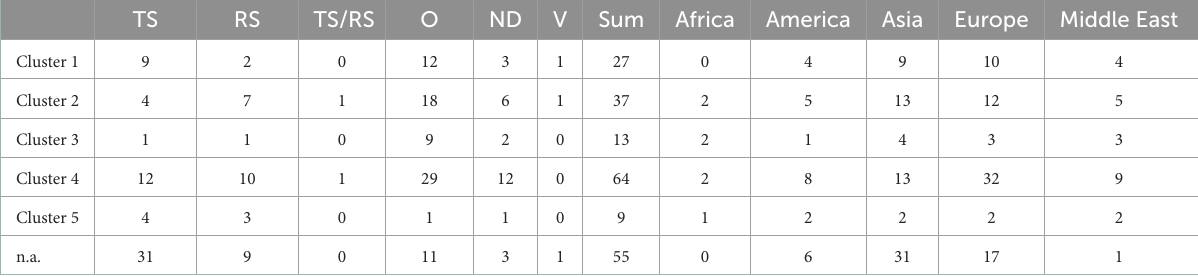
TABLE 1 Distribution of the clusters based on the diseases and geographical area. TS